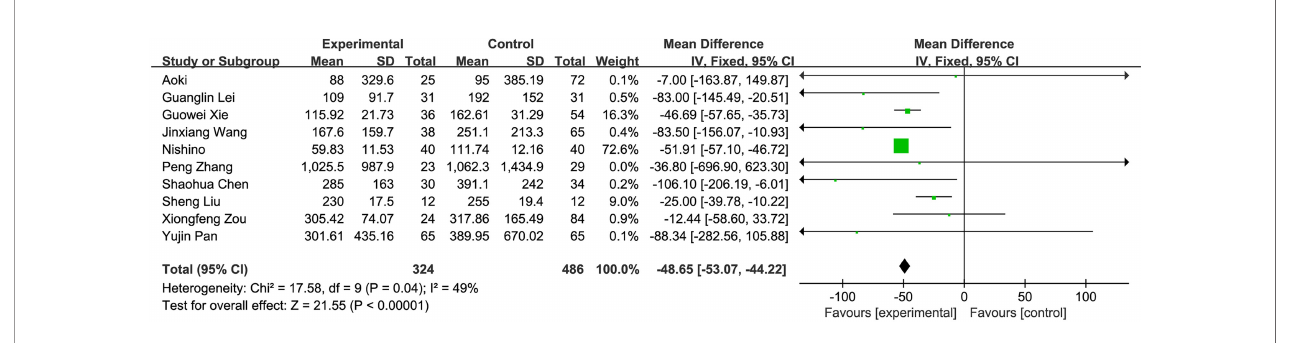
FIGURE 5 | Perioperative bleeding